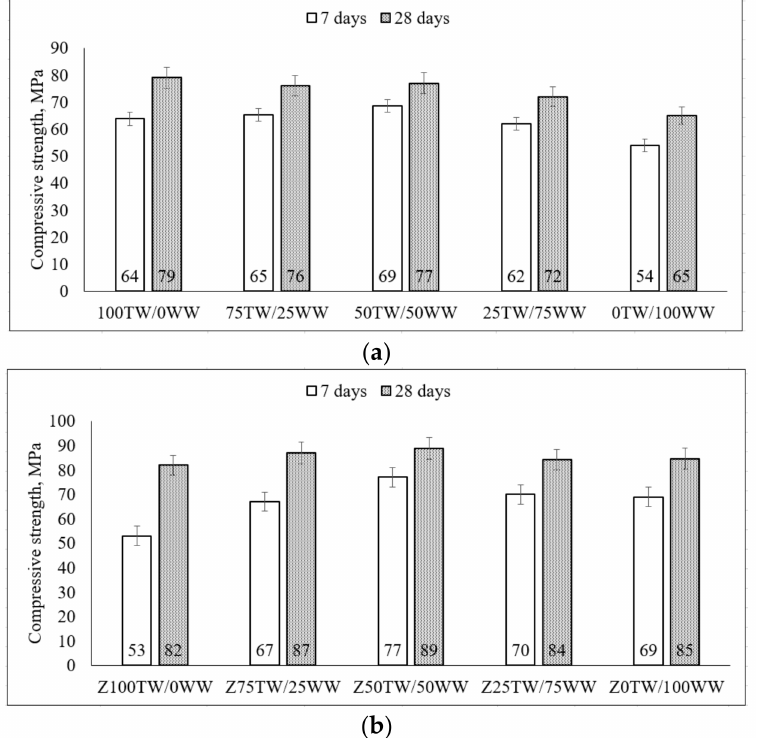
Figure 4. The compressive strength of hardened cement pastes with concrete wash water ( a ) and with the combination of concrete wash water and zeolitic by-product ( b ) at 7 days and 28 days. The mineral composition was determined by using XRD patterns (Figure 5). The mineral compositions of four samples (0TW/100WW, 50TW/50WW, Z0TW/100WW and Z50TW/50WW) were analyzed. These samples were chosen due to the highest compressive strength of the above-mentioned compositions (Figure